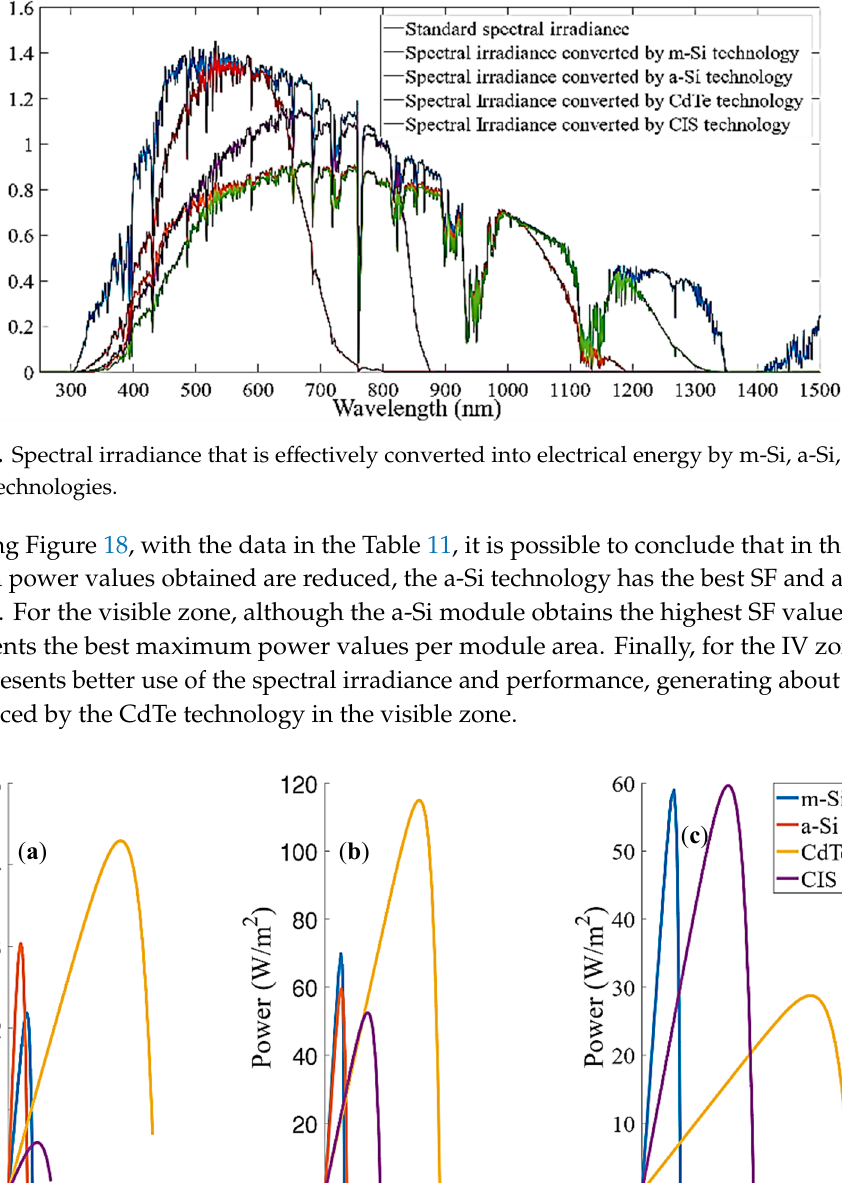
(UV) zone, 250–380 nm; ( b ) visible zone, 380–750 nm; and ( c ) infrared (IR) zone, > 750 nm.